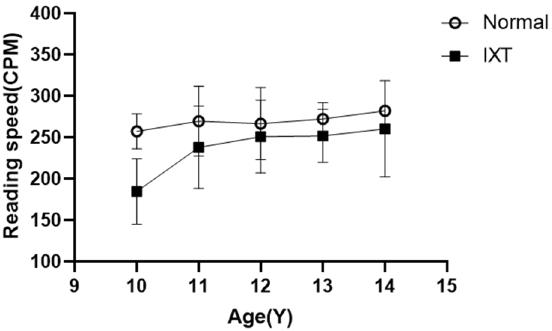
Figure 1. Comparison of reading speed by age between IXT and normal. CPM character per minute, Y year. Age factor: F = 3.98, p = 0.006 (**); Group factor: F = 21.33, p < 0.001 (***). Reading speed was slower in IXT than normal in each age group.